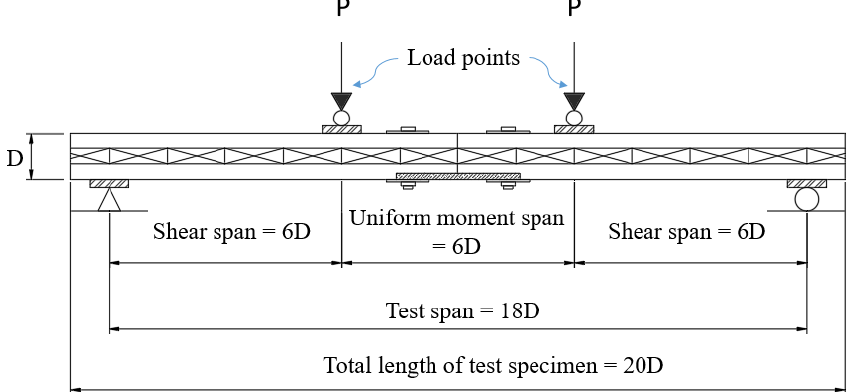
Figure 3. Four-point bending test setup used in the current study following AS/NZS 4063.1.